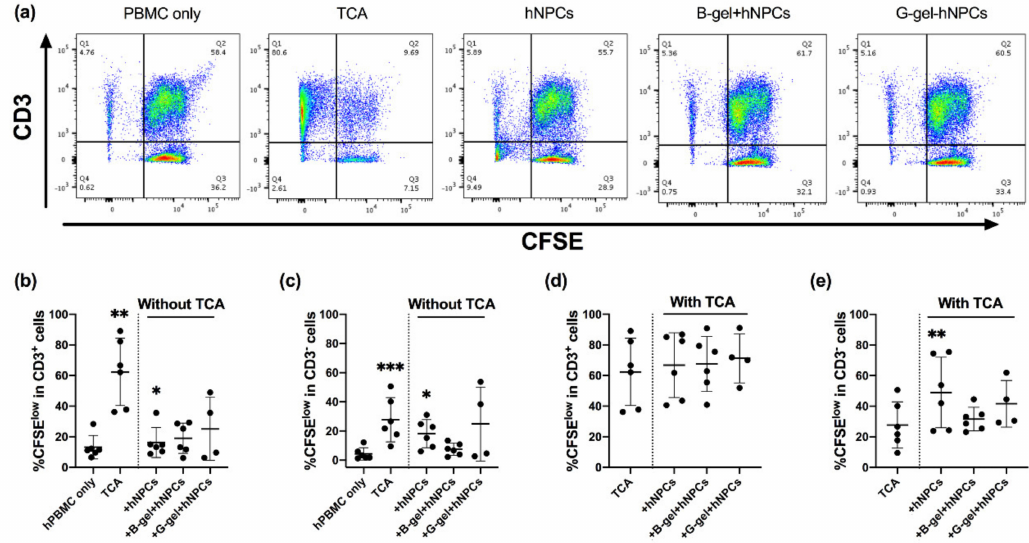
Figure 5. Proliferation of hPBMC subpopulations after co-culture with hNPCs in cell suspension or encapsulated in bulk or granular HA hydrogels for 5 d. ( a ) Representative flow cytometric data of the CFSE fluorescence intensity and frequency of CD3 expression. Frequencies of proliferated cells among resting ( b ) CD3 + cells and ( c ) CD3 − cells cultured with cell suspension of hNPCs or bulk/granular HA hydrogels with hNPCs encapsulated (with hPBMC-only groups and TCA-only groups as controls) or cultured in the same conditions after TCA treatment ( d , e ). Data are presented as mean ± SD. The vertical dotted line in the graph demarcates the control versus the experimental groups. The statistical test of mixed-effects analysis with Dunnett’s post hoc test was applied after log-transformation in order to compare the experimental groups with the control groups. Statistically significant differences from the hPBMCs-only group ( b , c ) or from the TCA group ( d,e ) are indicated as: * p ≤ 0.05, ** p ≤ 0.01, *** p ≤ 0.001. n = 4 biologically different hPBMC populations. Abbreviations: